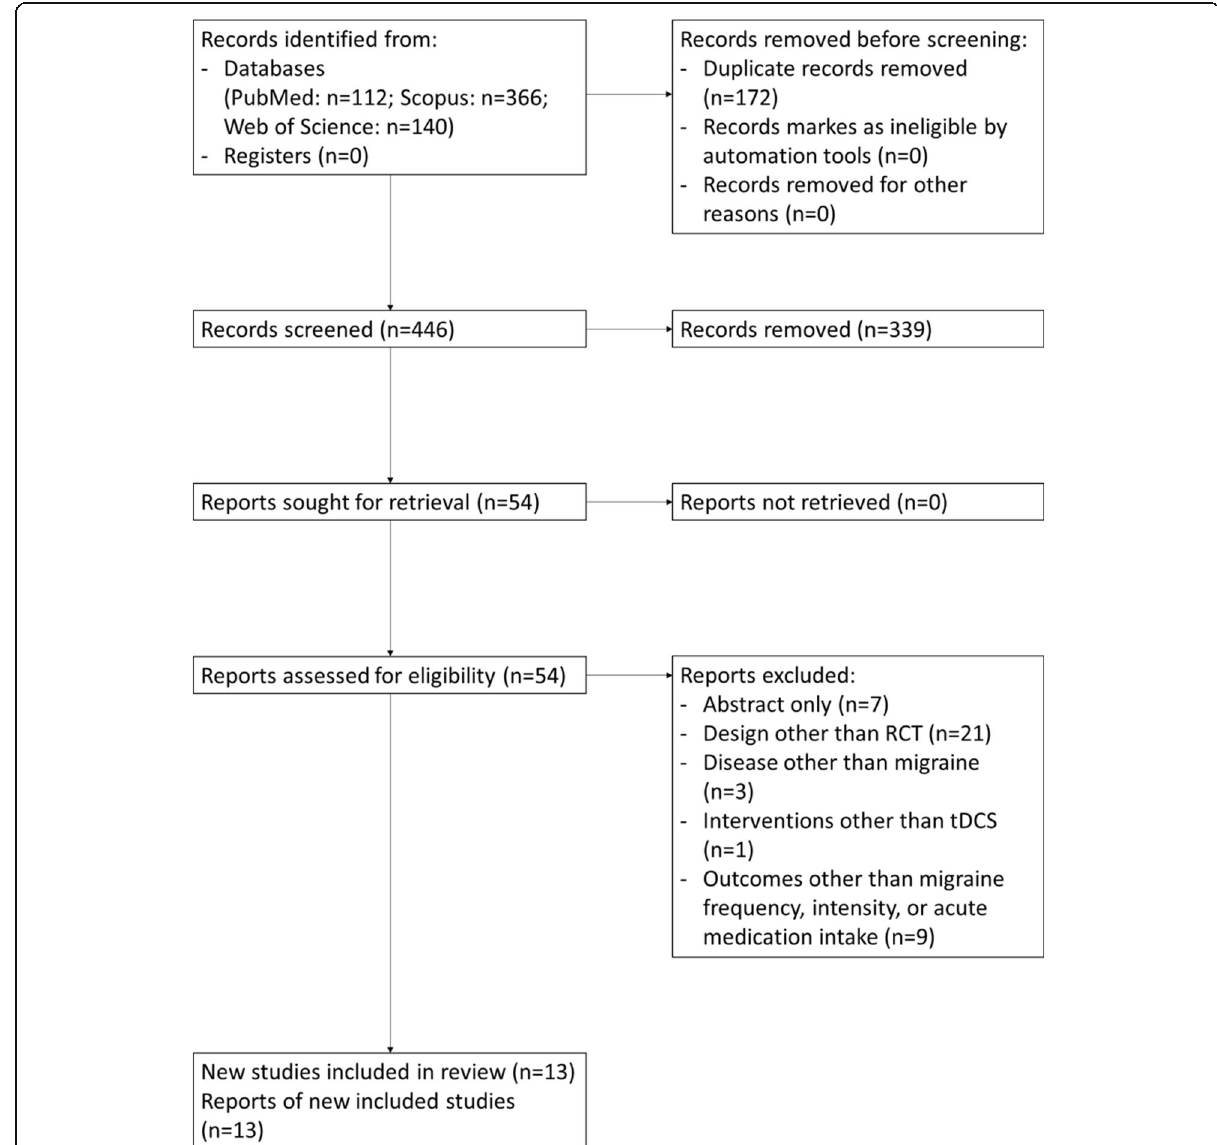
Fig. 1 PRISMA 2020 flowchart of study